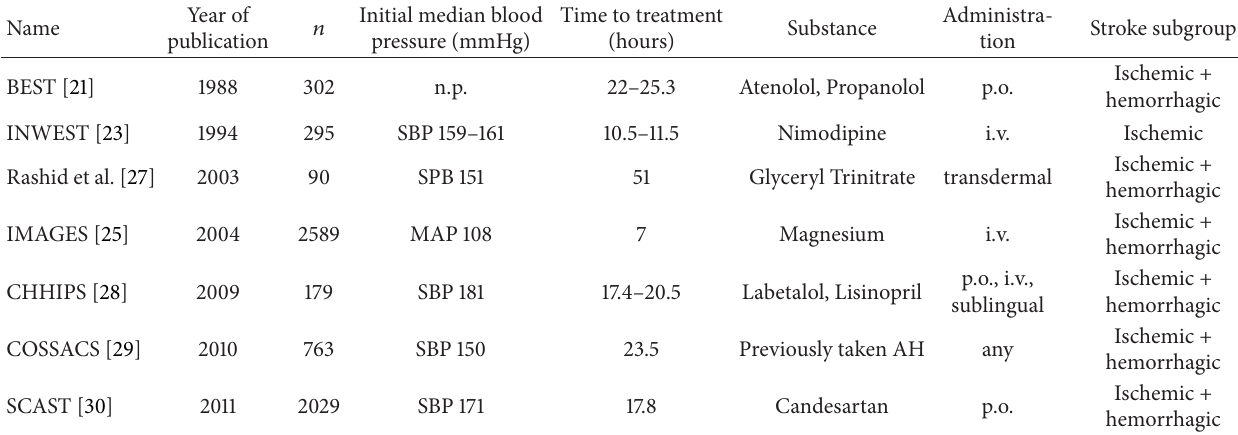
Table 1: Important randomised controlled trials of intervention versus control. SBP: systolic blood pressure, MAP: mean arterial pressure, AH: antihypertensive agents, p.o.: per os, i.v.: intravenous, n.p.: not published. (The phase II trial ACCESS comparing candesartan versus placebo has not been included, as the following phase III trial SCAST has